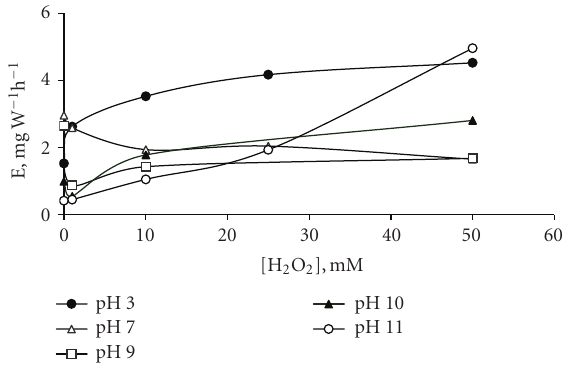
Figure 4: The dependence of the PCO e ffi ciency of lignin on hy- drogen peroxide concentration at di ff erent pH: initial concentration of lignin 100mg L − 1 , buoyant catalyst plane surface concentration 25 g m − 2 ; treatment time 24